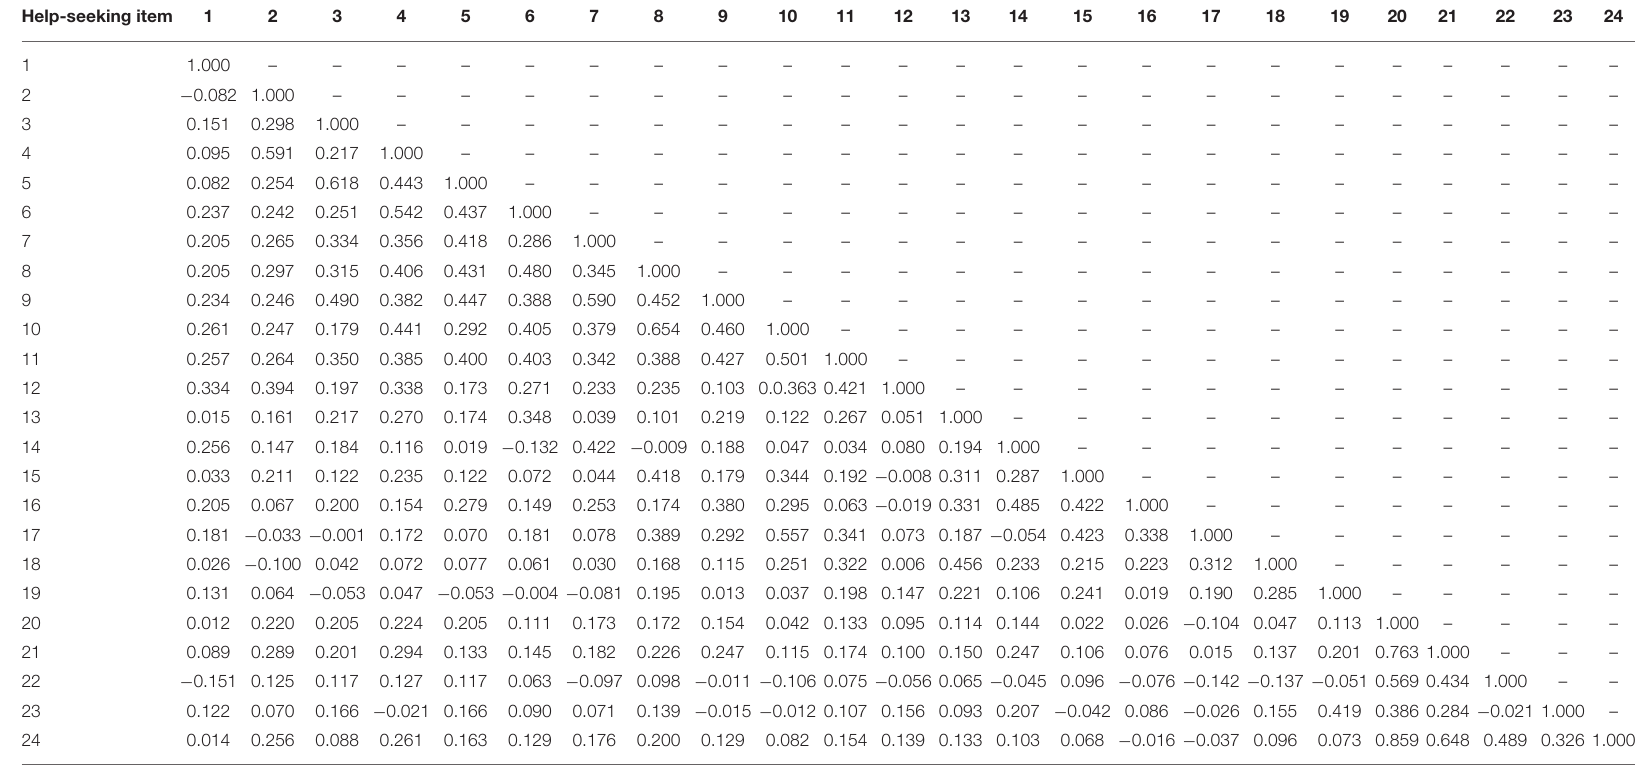
TABLE 7 | Inter-item correlation coefficients for mental health help-seeking behavior of Indonesian adolescents questionnaire. Help-seeking